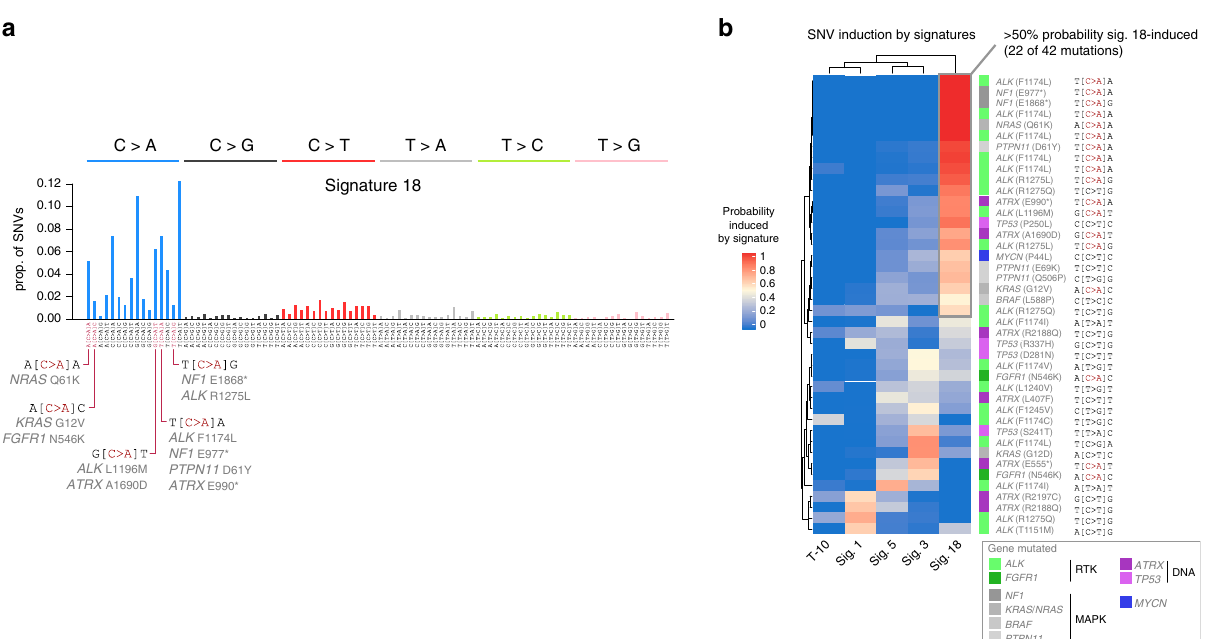
Fig. 5 Driver SNVs caused by signature 18. a Spectrum of signature 18, with 6 SNV types indicated at top and the trinucleotide context indicated at bottom. C>A mutations commonly affecting driver genes are indicated at bottom. b Heatmap showing probability that each somatic driver SNV (rows) was caused by each signature (columns). Each row represents one mutation in a speci fi c patient. Trinucleotide context of each mutation is indicated at right. Genes are color-coded as indicated in legend at bottom-right. Only driver SNVs in diagnosis WGS samples with highly reliable signature data (cosine reconstruction similarity of 0.9 or higher; n = 38 samples and 42 mutations) were analyzed. Source data are provided as a Source Data fi